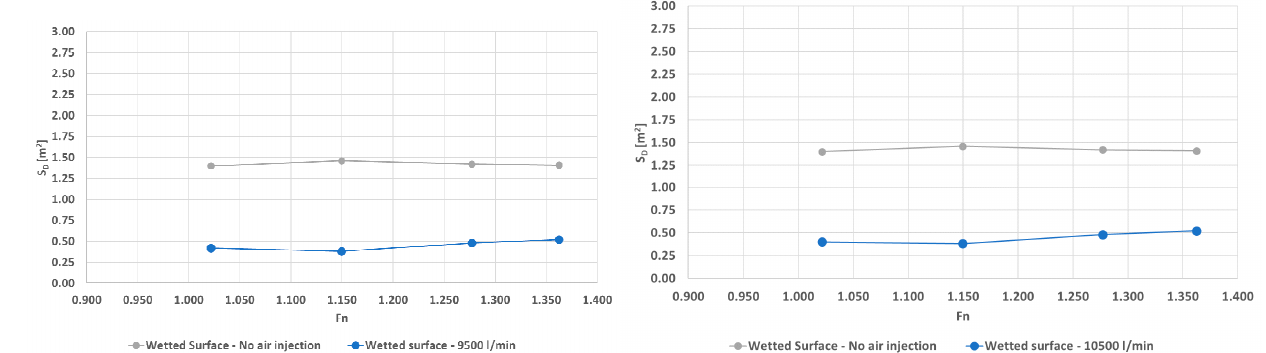
Figure 19. Wetted surface comparison–Air (9500 L/minand 10500 L/min) and No air.